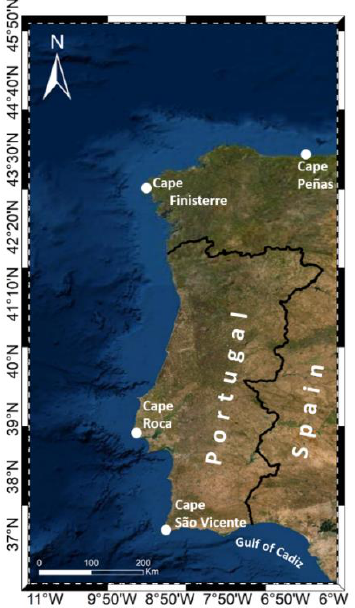
Figure 1. Study area with the main toponyms used in the study.